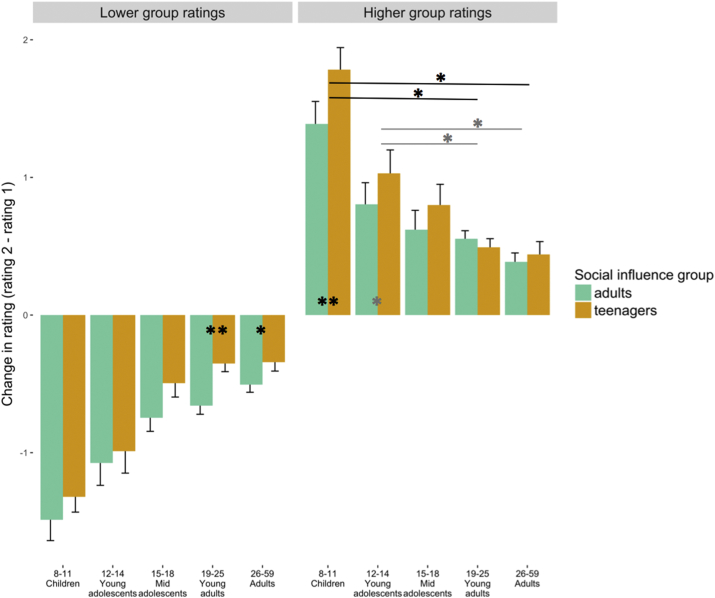
The graph shows the average differences in rating (ratings 2 minus rating 1) with standard error bars. Results are shown separately for the adult social-influence condition and the teenager social-influence condition, for each age group. Bars on the left (‘Lower group ratings’) were from the conditions in which the social-influence group rated risk lower than participants' initial rating. Bars on the right (‘Higher group ratings’) were from the conditions in which the social-influence group rated risk higher than participants' initial rating. Asterisks indicate significant main effect of peer-influence (adults vs teenagers) within age group and interaction on peer-influence effects between age groups (** p < 0.01, * p < 0.05, black: Bonferroni corrected result; grey: uncorrected result).